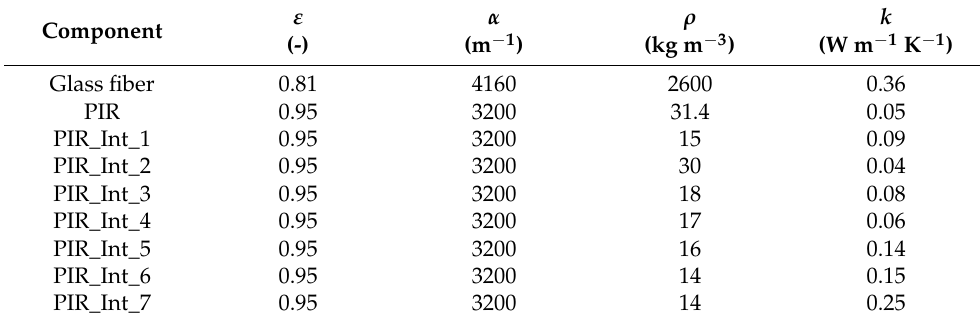
Table 4. Thermal transport properties of condensed-phase components of the PIR foam.